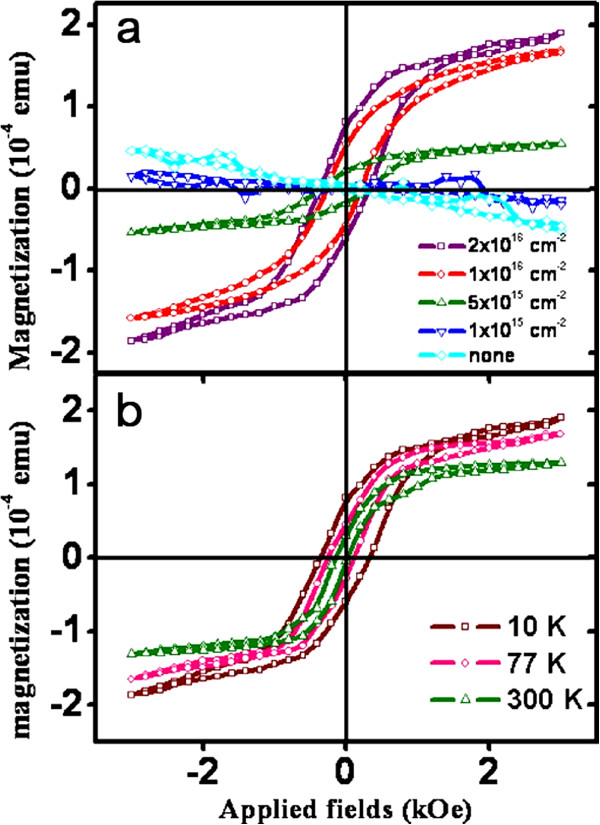
Hysteresis loops measure at various temperatures. Hysteresis loops (a) measured at 10 K for Si nanowires Mn+-implanted to doses of 1 × 1015, 5 × 1015, 1 × 1016, and 2 × 1016 cm-2 and (b) taken at 10, 77, and 300 K for Si nanowires Mn+-implanted to a dose of 2 × 1016 cm-2. Reprinted with permission from Wu et al. [61].